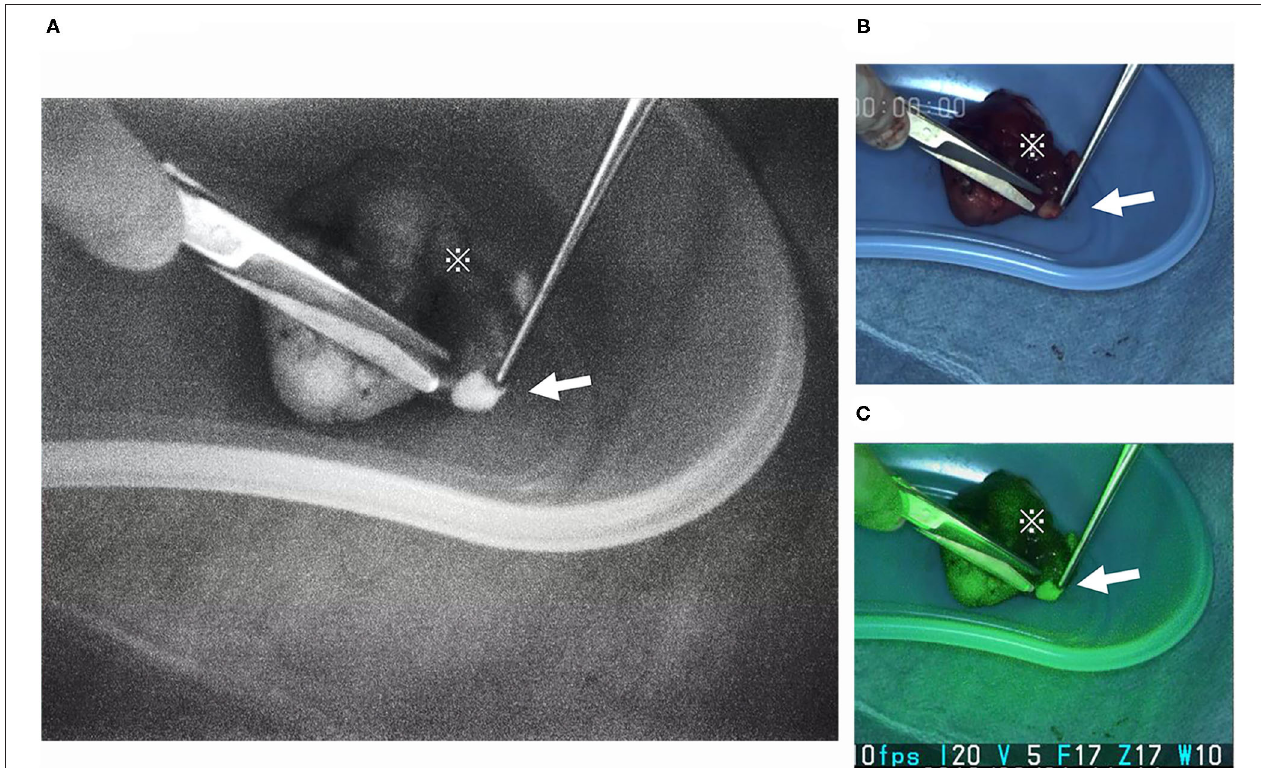
FIGURE 6 | Extraction of the parathyroid gland at the back table in the operating room. The parathyroid gland (arrow) is often embedded with in the lower pole of the excised thyroid ( ※ ). The parathyroid gland is easily detected and located with the NIR camera. The projection source of the pde-neoII was used. The image is visualized using the LIGHTVISION NIR camera. This device enables three screens visualizing: (A) the NIR fluorescence, (B) the optic white light, and (C) the optic and modified NIR fluorescence screen visions projected simultaneously. NIR, near